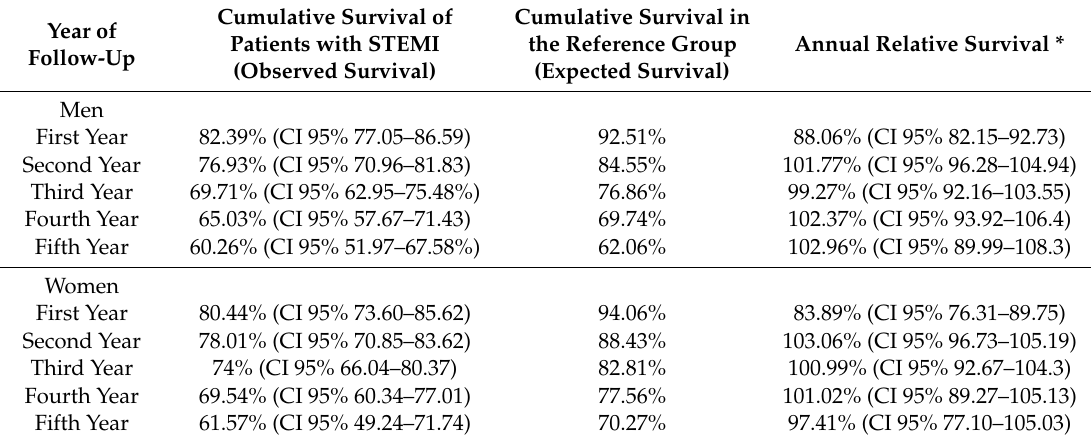
Figure 3. Relative survival by year of follow-up and stratified by sex. Table 4. Observed and expected survival during the follow-up stratified by sex and calculated by year of follow-up. Relative survival by annual intervals were also calculated. CI: Confidence Interval; STEMI: ST elevation myocardial infarction.